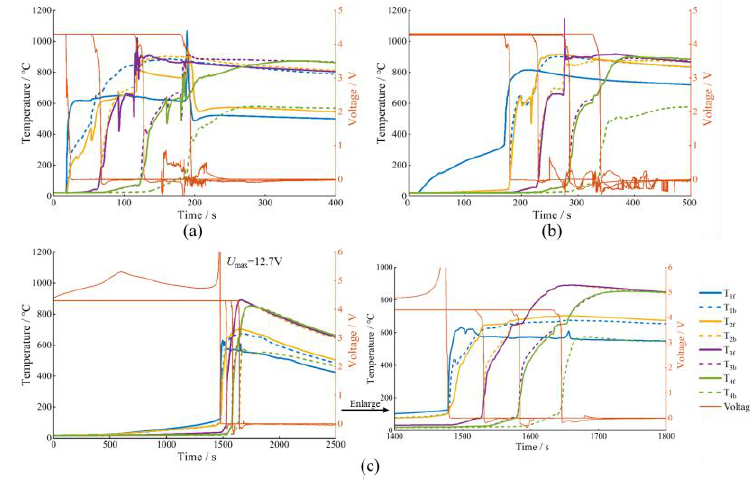
Figure 12. TRP temperature and voltage with different trigger methods. ( a ) Nail penetration; ( b ) Side heating; ( c ) Overcharge.